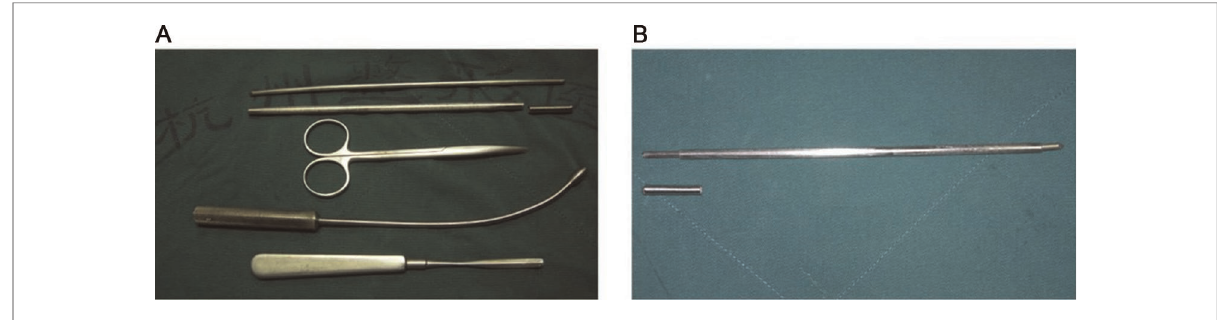
FIGURE 1 The capsule contraction-releasing devices. ( A ) All the devices. From top to bottom are a double-headed separating rod, a sleeve and cap, a straight vascular clamp, an olive-head splitter, and a blunt stripper. ( B ) The double-headed separating rod in the sleeve and sleeve